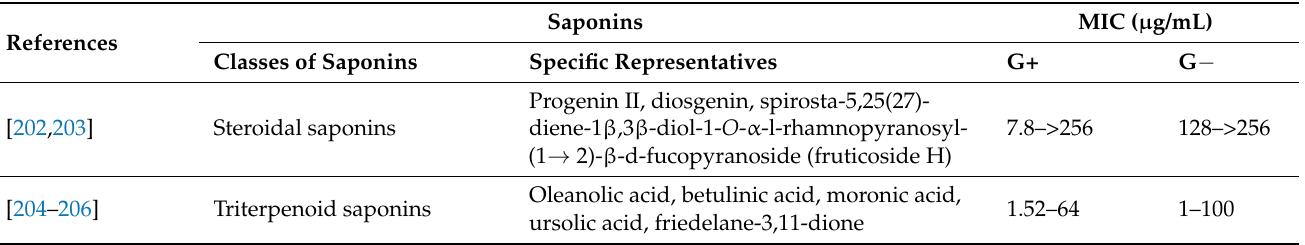
Table 7. The minimum inhibitory concentrations of selected saponins against gram-positive and gram-negative bacteria.